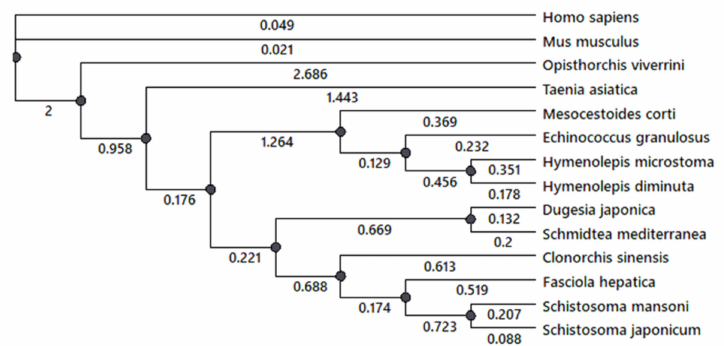
Figure 4. A phylogenetic tree of serotonin 5-HT 7 receptors in cestodes, trematodes and planarian species with the annotated genome